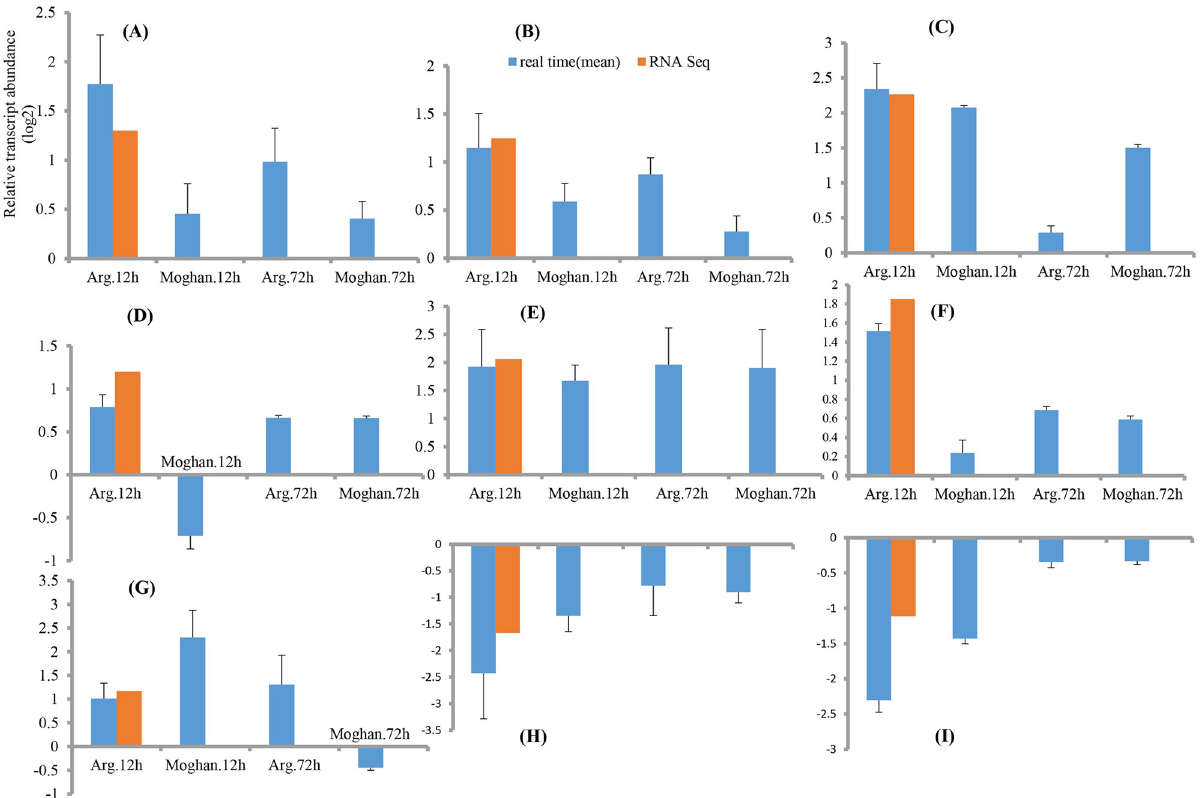
Fig 4. Validation of the candidate genes by qRT-PCR including bHLH transcription factor 35 (A), calcineurin B-like protein (CBL)-interacting protein kinase 23 (B), ethylene responsive factor 061 (C), heat shock transcription factor B1 (D), NAC transcription factor (E), pyrroline-5-carboxylate synthetase (F), salt response protein (G), Ribuluse biphosphate carboxylase small chain (H), and Phosphoglycerate Kinase (I). Refer to S1 Table to find the gene ensemble IDs.